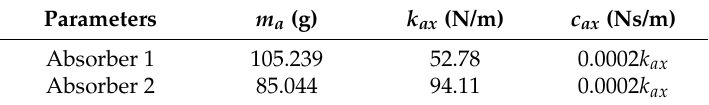
Table 4. Parameters of the designed conventional linear absorbers.